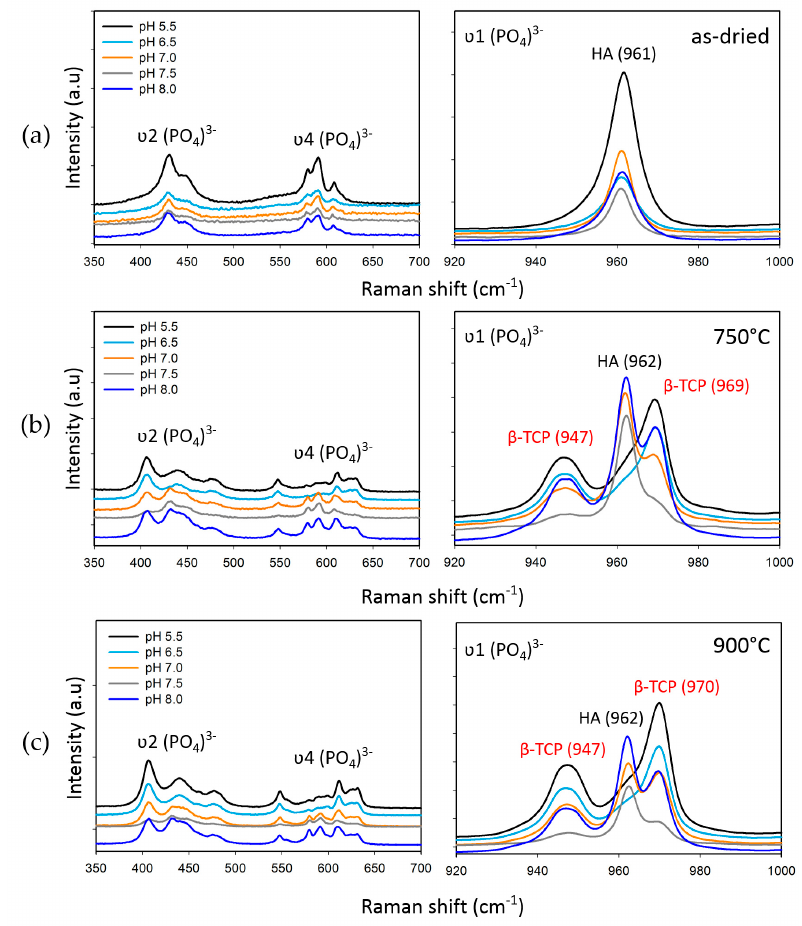
Figure 7. Raman spectra of the samples obtained at different conditions of pH and sintering temperature. The alterations in the (PO 4 ) 3 − ν 1, ν 2, and ν 4 vibration bands for each synthesis condition are given: ( a ) Corresponding vibration bands of the as-dried samples; ( b ) corresponding vibration bands of the samples sintered at 750 °C; ( c ) corresponding vibration bands of the samples sintered at 900 °C.